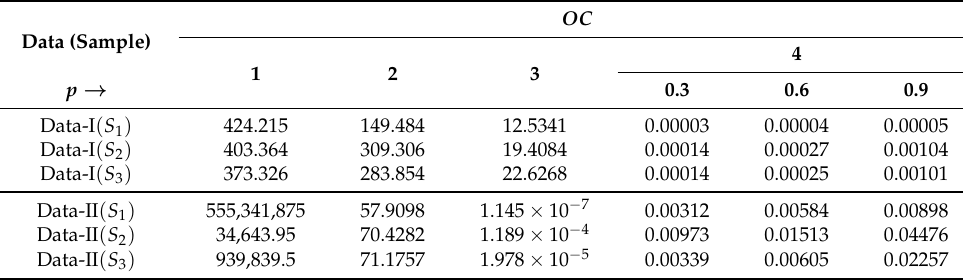
Table 7. Optimum censoring schemes under different criteria for the generated samples.